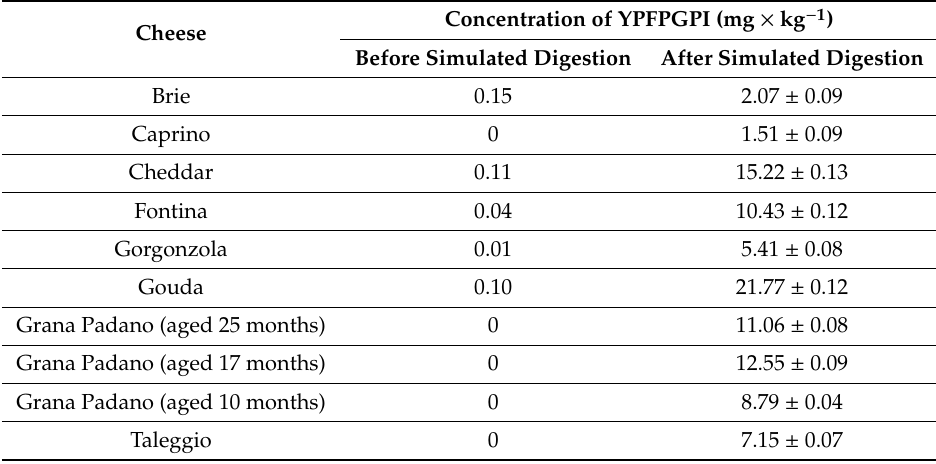
Table 2. The Concentration of YPFPGPI in commercial cheeses before and after in vitro simulated gastro-intestinal digestion. Adapted with permission from [33], Copyright Elsevier,